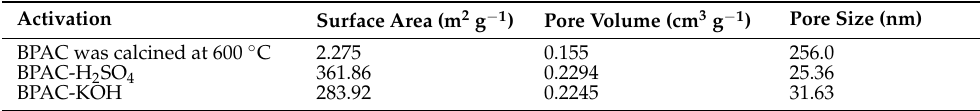
Table 1. Preliminary results for the activation of